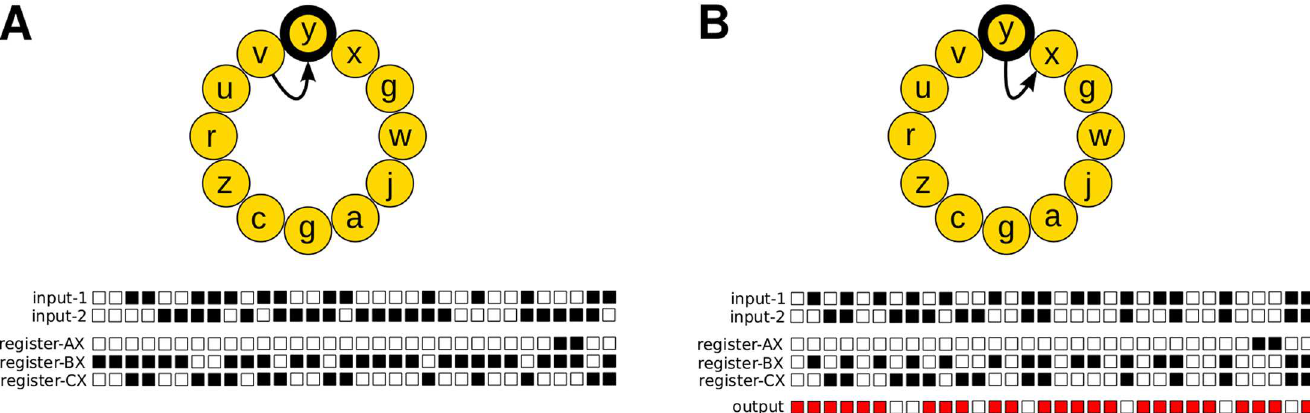
Fig 1. The genotype encodes the phenotype of a digital organism. The genotypeof a digital organism with the smallest genome requiredto perform the logic operationNAND is depictedas a circular set of 12 instructions (represented here as letters). Beyondthe instructions necessary for copyingthe genome,the geneticlanguageof Avida containsinstructionsfor storing and manipulating 32-bit binary numbers in buffers (input-1 and input-2) and registers (AX, BX, and CX). Each binary number is represented here as a sequenceof 32 boxes, one for each bit. The value of each bit is depicted as a black box if it equals one and as a white box if it equals zero. The cartoon shows the executionof the input-output instruction(represented by the letter y ; highlighted in black). ( A ) The state of the input buffers and registers before executingthe input-outputinstruction(the arrow points toward the next instructionto be executed). ( B ) The state of the input-buffers, registers, and the output after executingthe input-outputinstruction. The input-output instructionoutputs the numberstored in the BX register, checking for any logic operationthat may have been performed on the two binary numbers previously stored in the input buffers. In this example,the output is the result of applyingthe logic operationNAND: for each bit pair, the result is 0 (white box) if and only if the two bits are 1, and 1 otherwise(red box). Then, the input-output instructionplaces a new randombinary number into the BX register (a numberthat is also stored in the input-1 buffer after moving the number previously stored there to the input-2 buffer). The completestep-by-step self- replication cycle of this digital organism is shown as S1 Appendix.Note that, in our study, the genome of digitalorganismsis much larger (i.e., 100 instructions